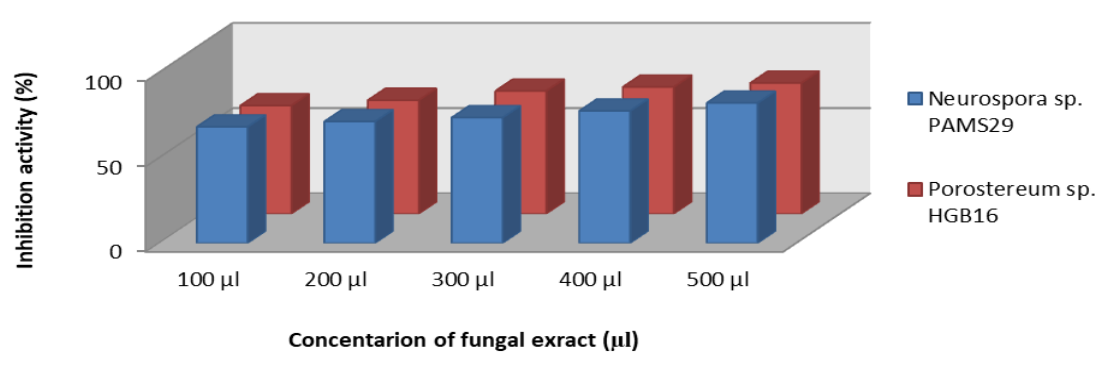
Figure 7. DPPH free radical scavenging activity of Porostereum sp. HGBS16 and Neurospora sp. PAMS29